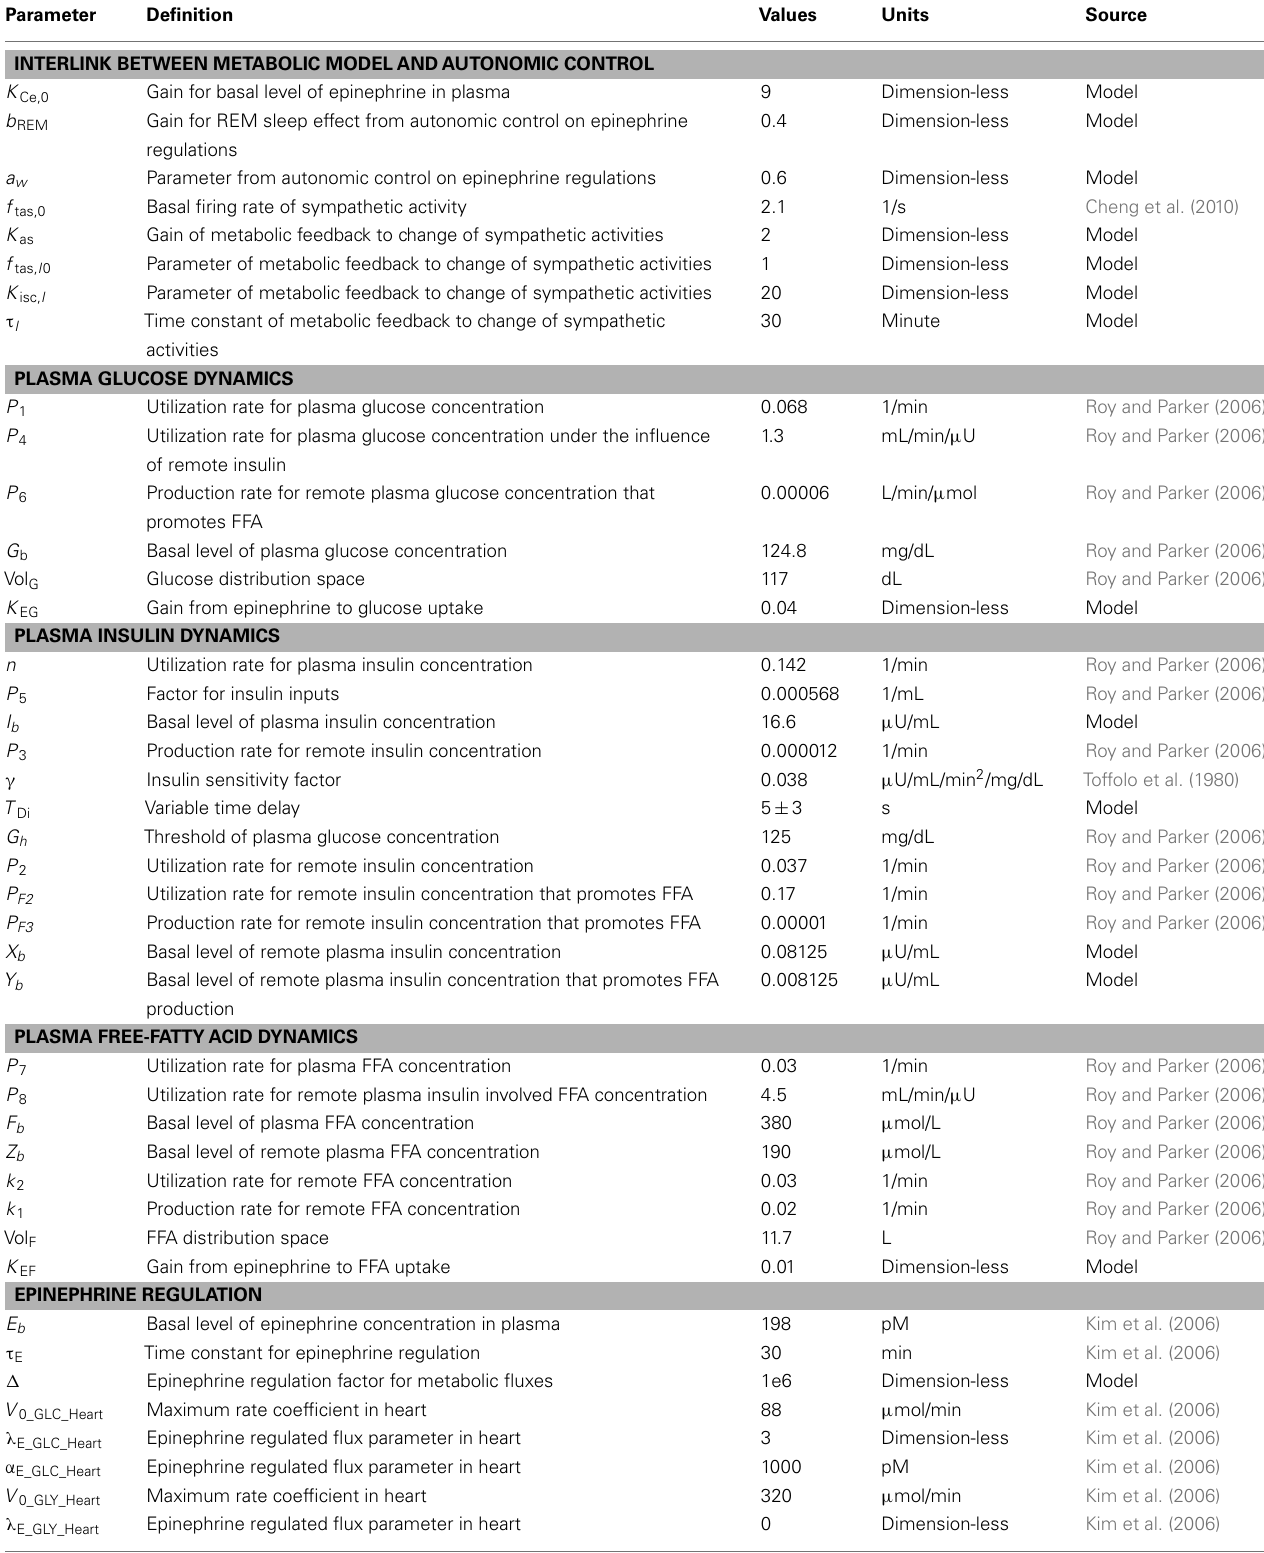
Table 1 | Simulation parameters and initial conditions in metabolic model and its link with autonomic